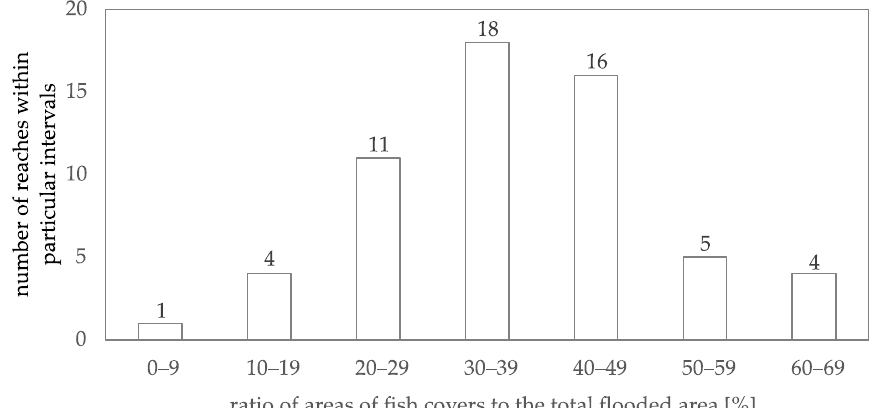
Figure 3. Histogram of the number of streams with the ratio of areas of fish covers to the total flooded area.